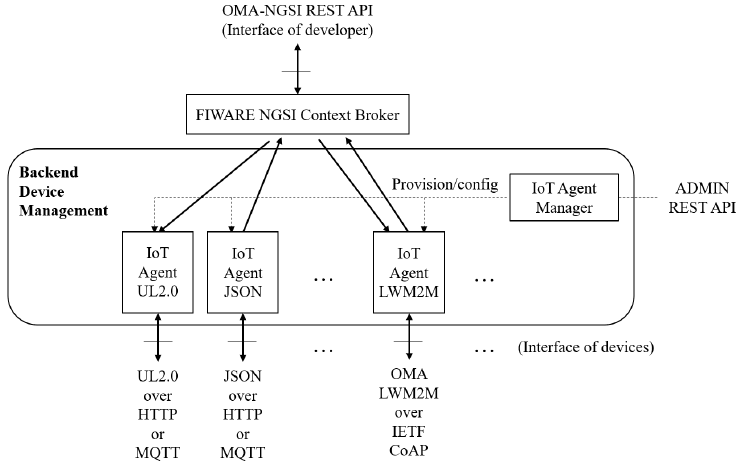
Figure 5. Interaction between Orion context broker and intelligence data advanced solution (IDAS) generic enablers (GEs).